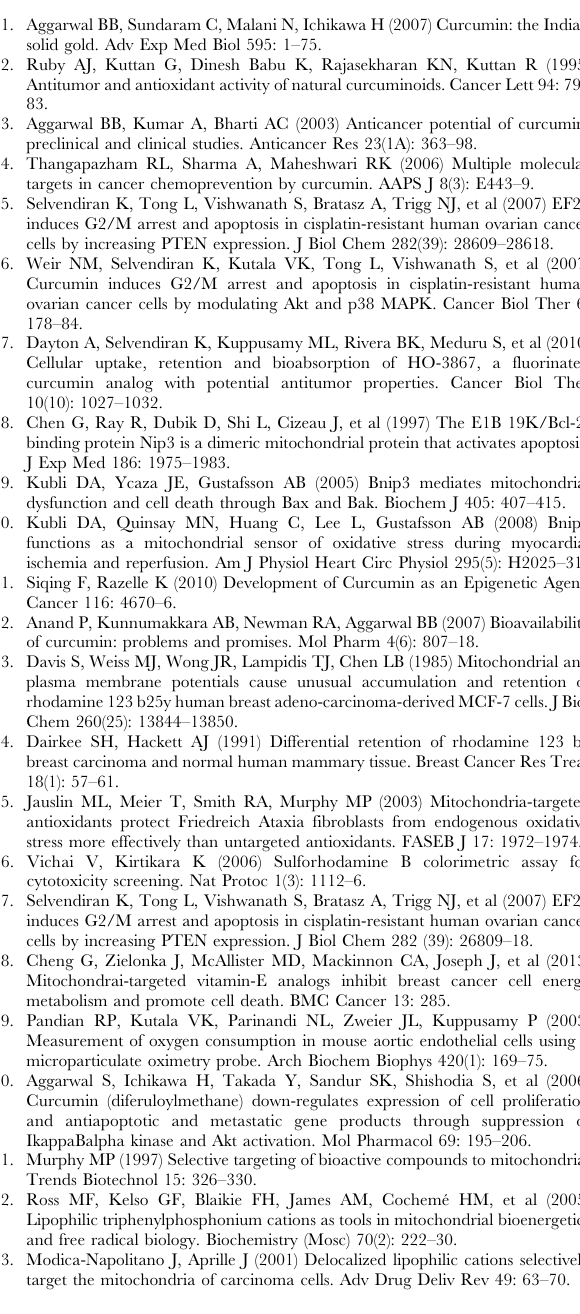
Figure S8 Cell Viability of MCF-10A treated with various concentrations of curcumin and mitocurcumi- noids. MCF-10A cells were incubated with various concentra- tions of curcumin and mitocurcuminoids-1, 2 and 3 for 24 h. At the end of treatments, cell viability was assayed by SRB assay. (TIF) Figure S9 Cell Viability of MCF-10A treated with various concertrations of triphenylphosphonium (TPP + ). MCF-7 cells were incubated with various concentrations